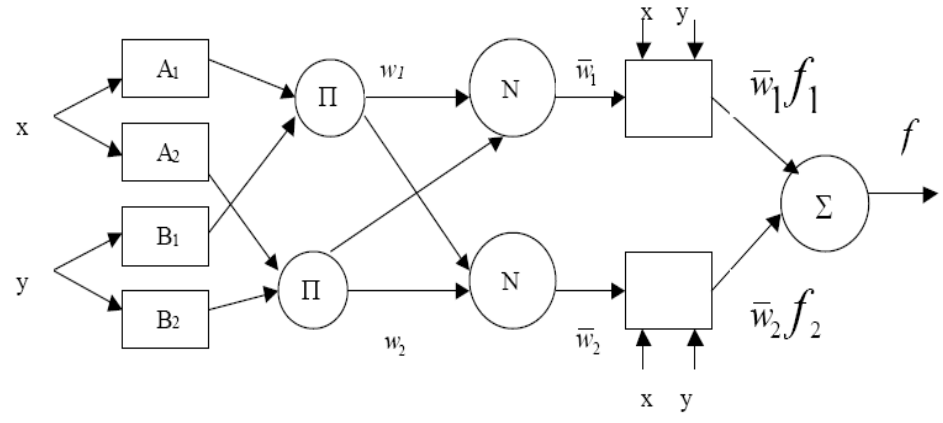
Figure 3. Structure of five-layer ANFIS.